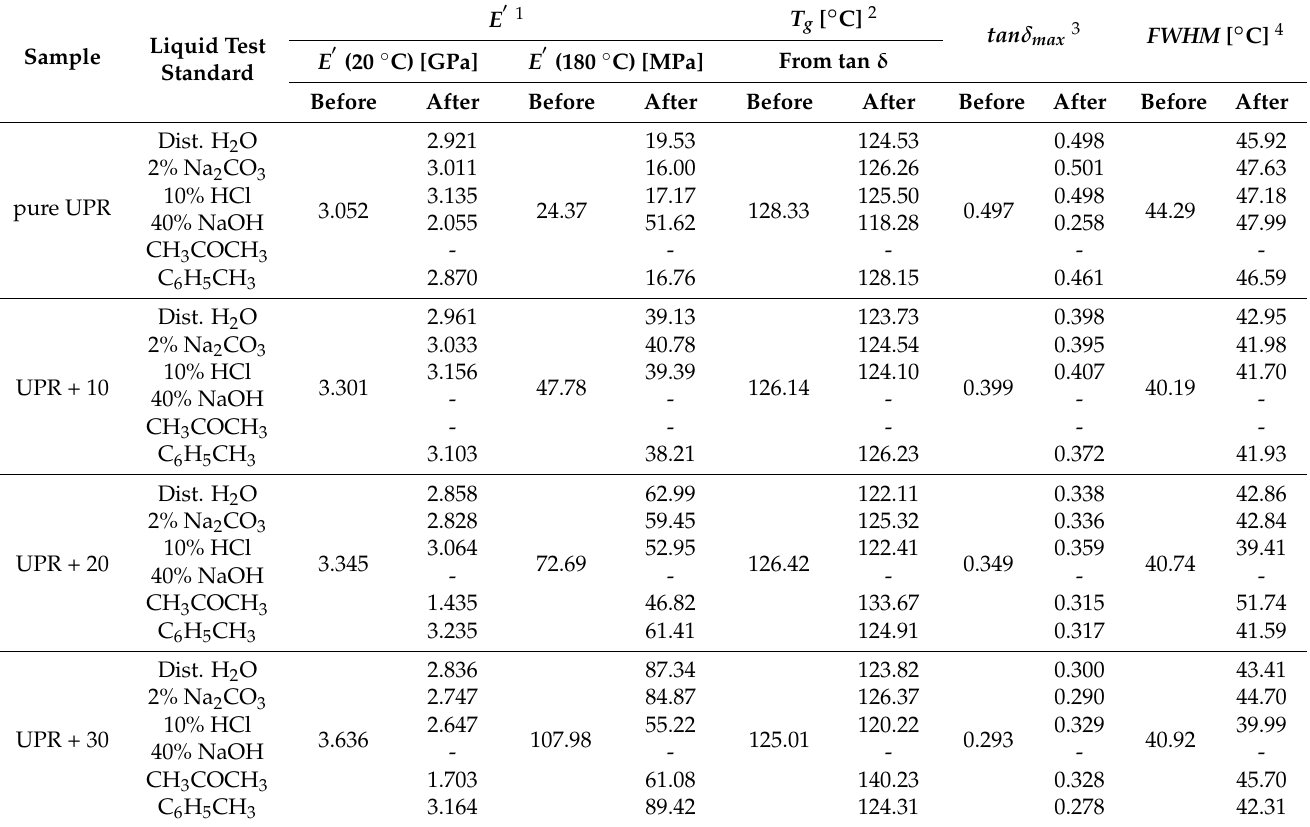
Table 5. Thermomechanical data for the UPR/PSP composites before and after the immersion test.